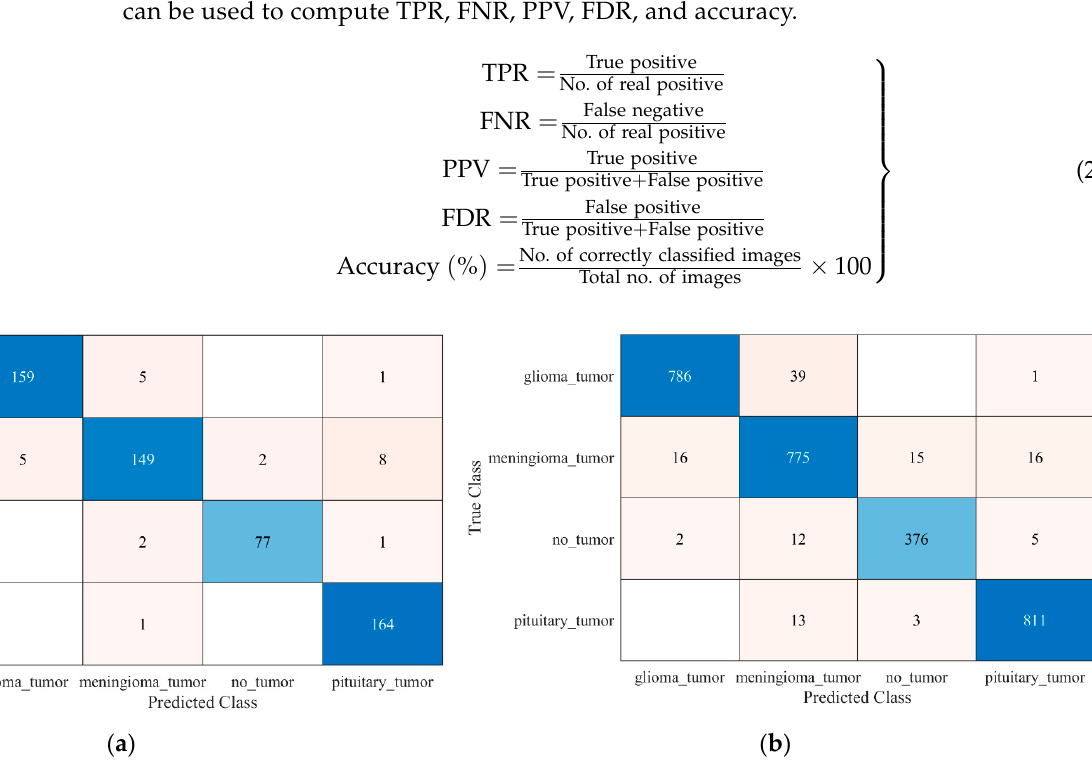
Figure 6. Confusion matrix of the proposed WBM-DLNets for brain tumor detection: ( a ) 0.2-holdout; ( b ) five-fold cross-validation. Table 4. Results of WBM-DLNets for tumor